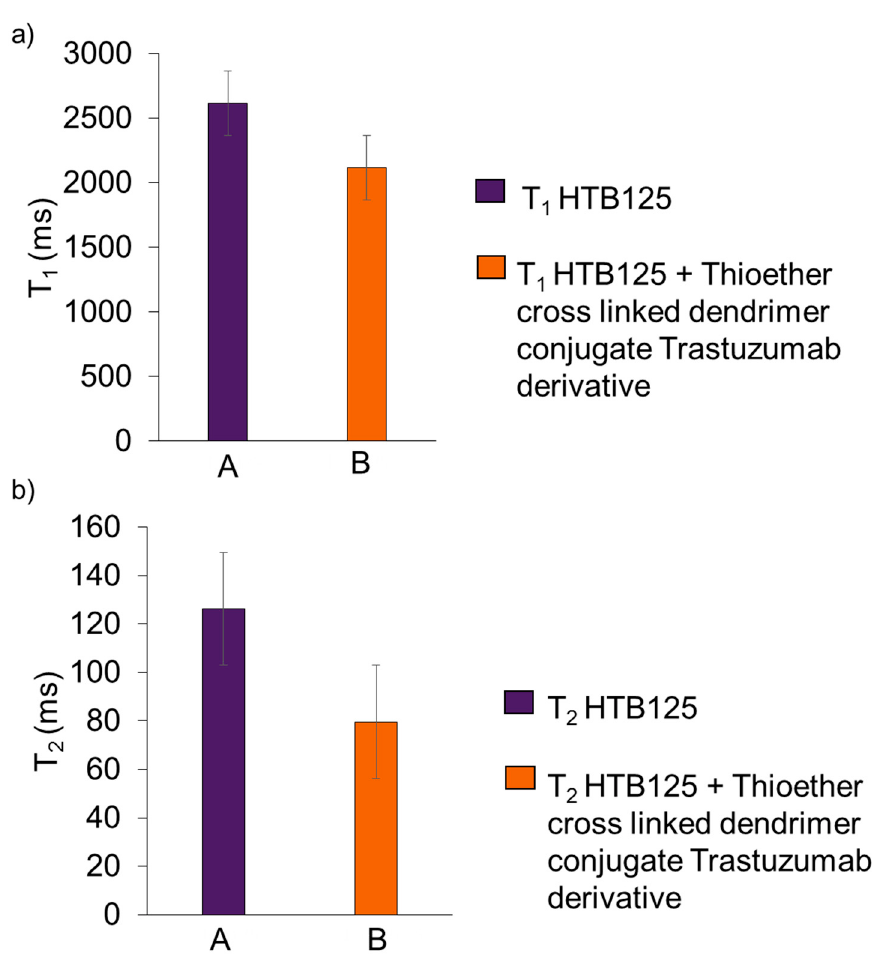
Figure 9. Results of T 1 ( a ) and T 2 ( b ) relaxation times for HTB-125 cell culture (A), and the same culture with the addition of Thioether cross linked dendrimer conjugate Trastuzumab derivative (B).